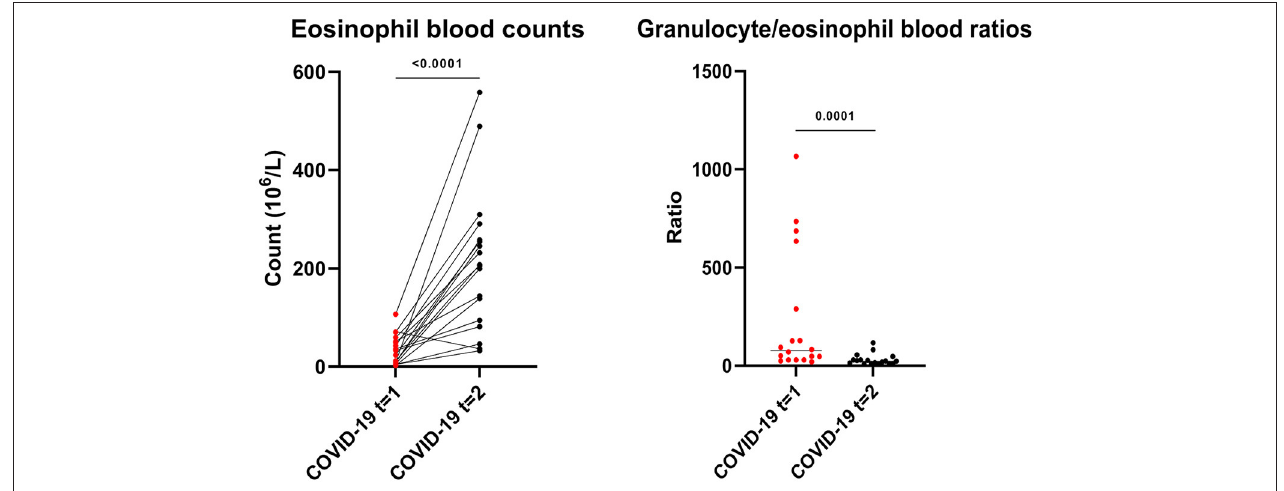
FIGURE 5 | Eosinophil blood counts and granulocyte/eosinophil blood count ratios during ( t = 1) and 3 to 6 months after ( t = 2) active COVID-19 disease in primary care patients. Statistical significance was tested using the Wilcoxon matched-pairs signed rank